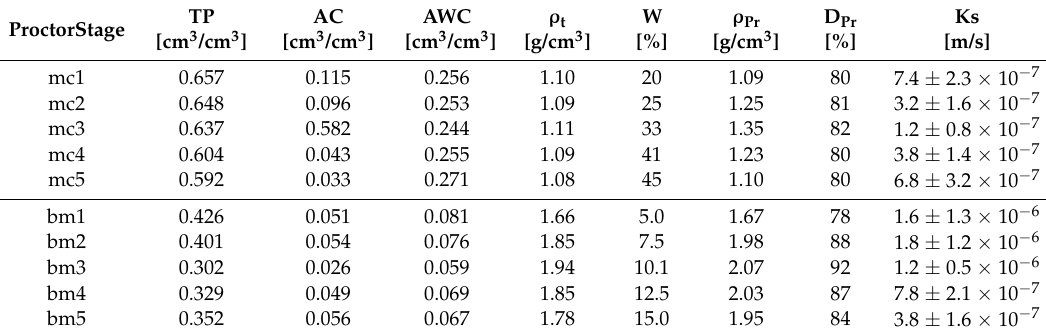
Figure 2. Moisture content (w, %), Proctor density (Pr) and the degree of proctor density (D Pr , %) of five different Proctor stages of the boulder marl (bm1-5) and the clay (mc1-mc5), respectively (n = 4). Table 3. Soil physical properties of the investigated clay (mc1-mc5) and boulder marl (bm1-bm5) considering the shrinkage-dependent volume changes for the average total porosity (TP), air capacity (AC), the plant available water capacity (AWC), moisture content (w), proctor density ( ρ Pr ), and degree of proctor density (D Pr ), n = 10 soil cores per Proctor stage. The symbol ± corresponds to the standard deviation.